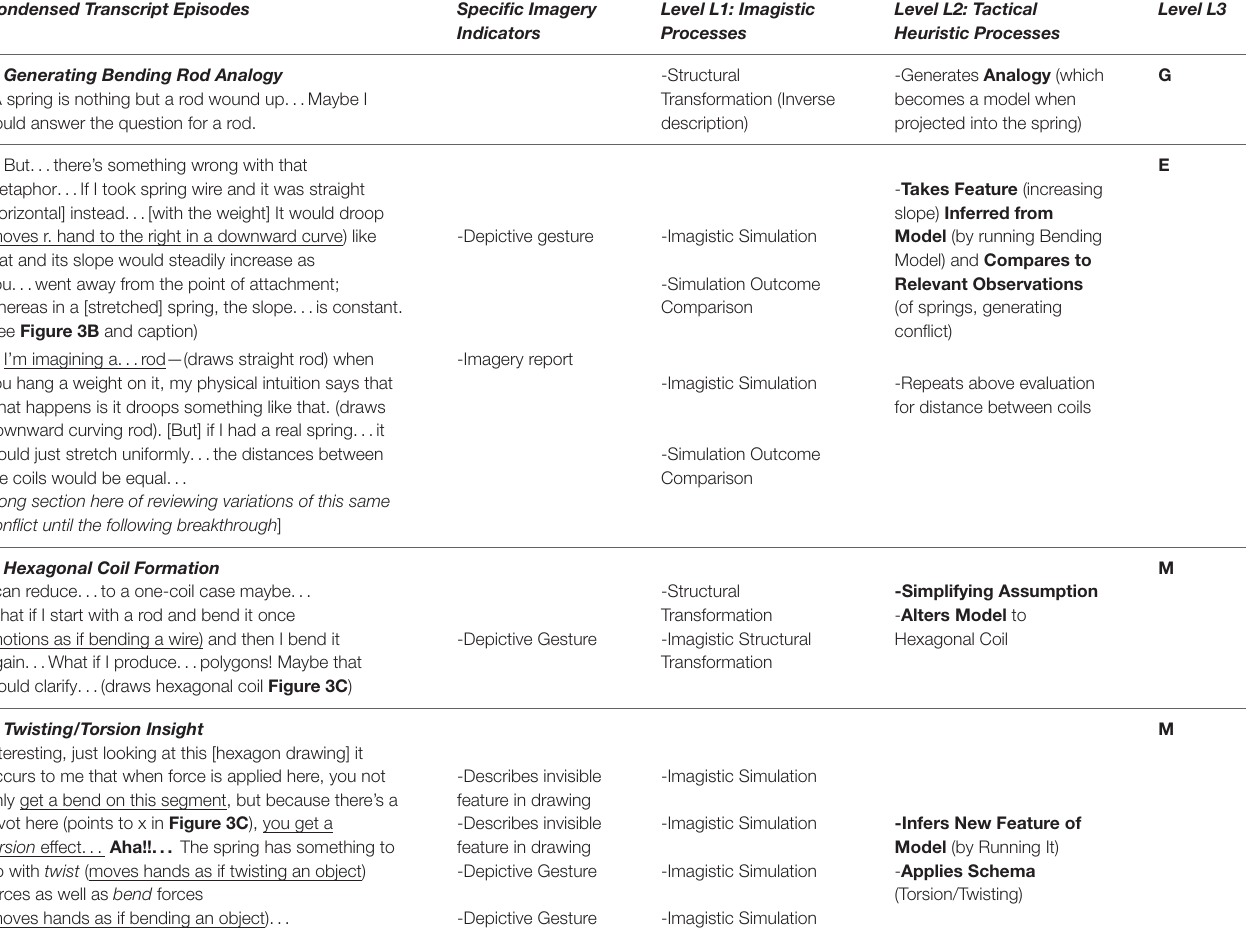
TABLE 2 | Processes used for developing a model in mechanics. In column 5 G, E, M, = Model Generation, Evaluation, or Modification. In column 1 parentheses indicate subject’s actions; brackets indicate my clarifications. Underscores identify evidence for imagery use (kinesthetic or visual), described in column 2. Terms in bold in column 4 are Level L2 reasoning processes. Also see Figure 3